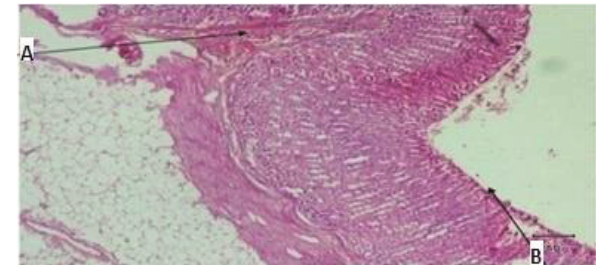
Fig-6: H & E stained slide of mirtazapine pretreated group showing following